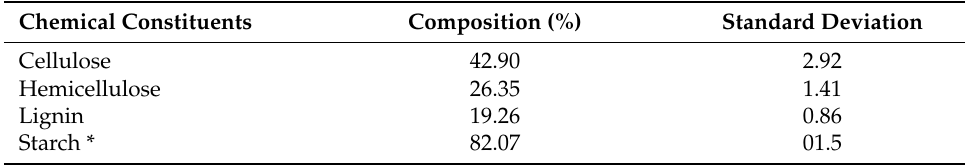
Table 1. Chemical composition of oil palm trunk lumber.